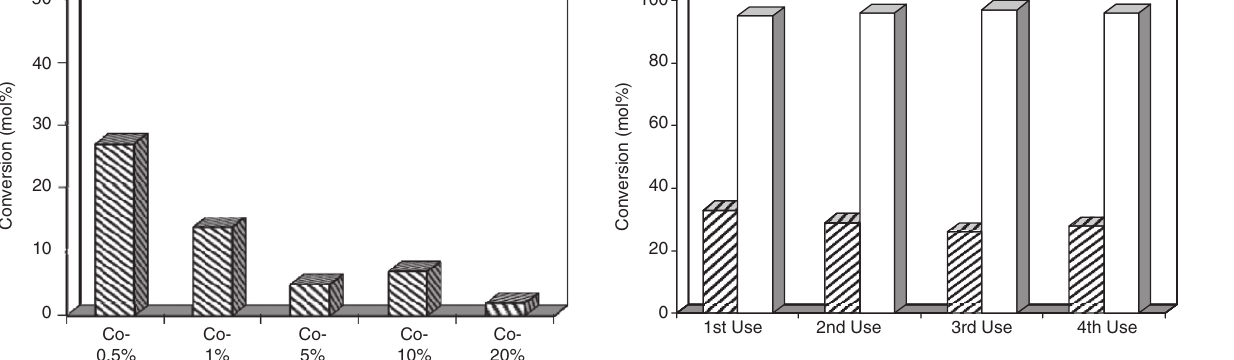
Figure 4 Activities of Co-containing catalysts (with cobalt contents ranging from 0.5 to 20%) in the microwave-assisted oxidation of benzyl alcohol. Reaction conditions: 2 ml solvent, 0.2 ml benzyl alcohol, 0.3 ml H O (50% v:v) and 0.050 g catalyst, microwaves, 2 2 300 W, 70–80 ° C, 5 min reaction.